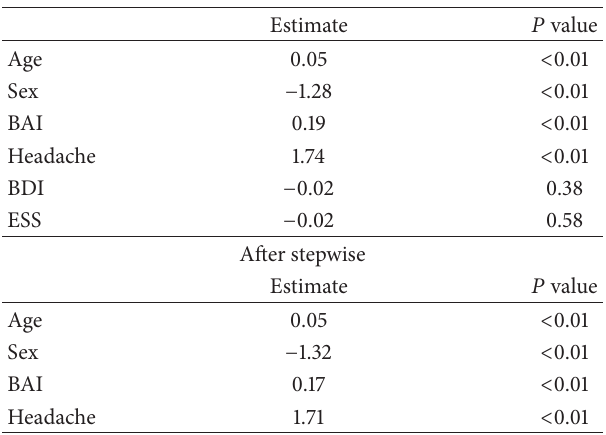
Table 4: Results of propensity score model.